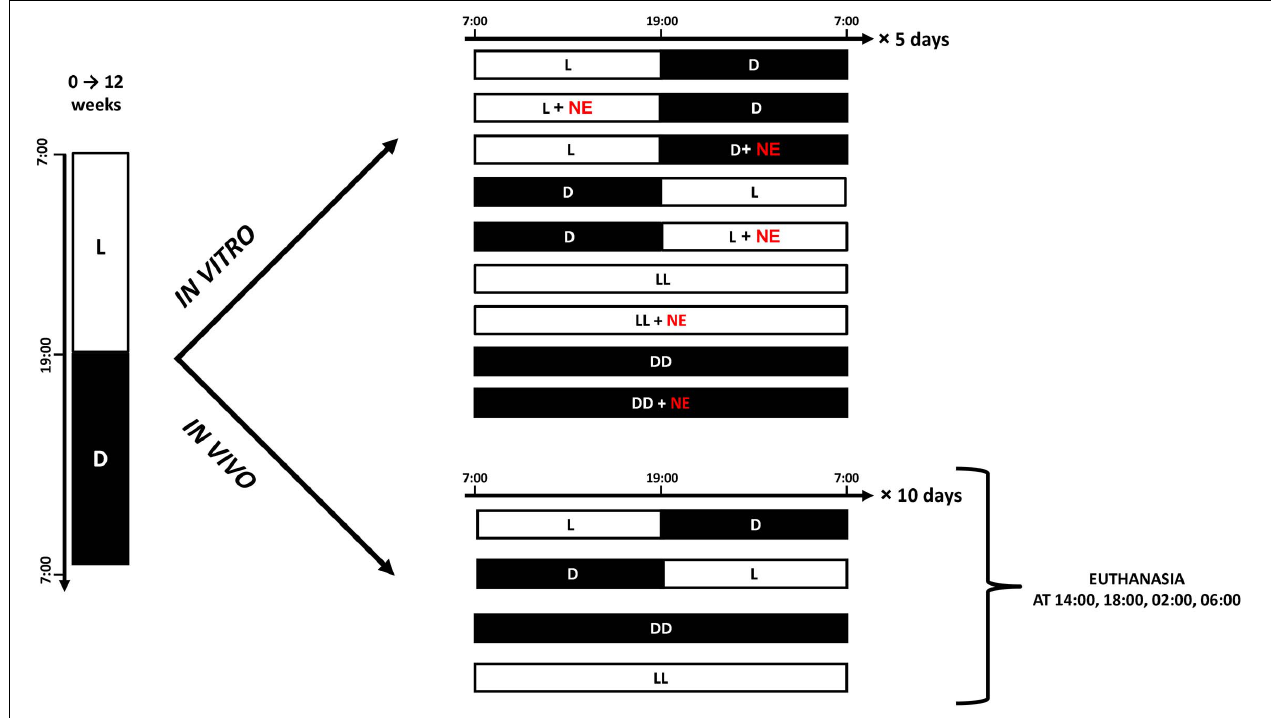
FIGURE 1 | Cartoon presents experimental protocols for in vitro and in vivo experiments. White bars indicate photophase; black bars indicate scotophase; NE,